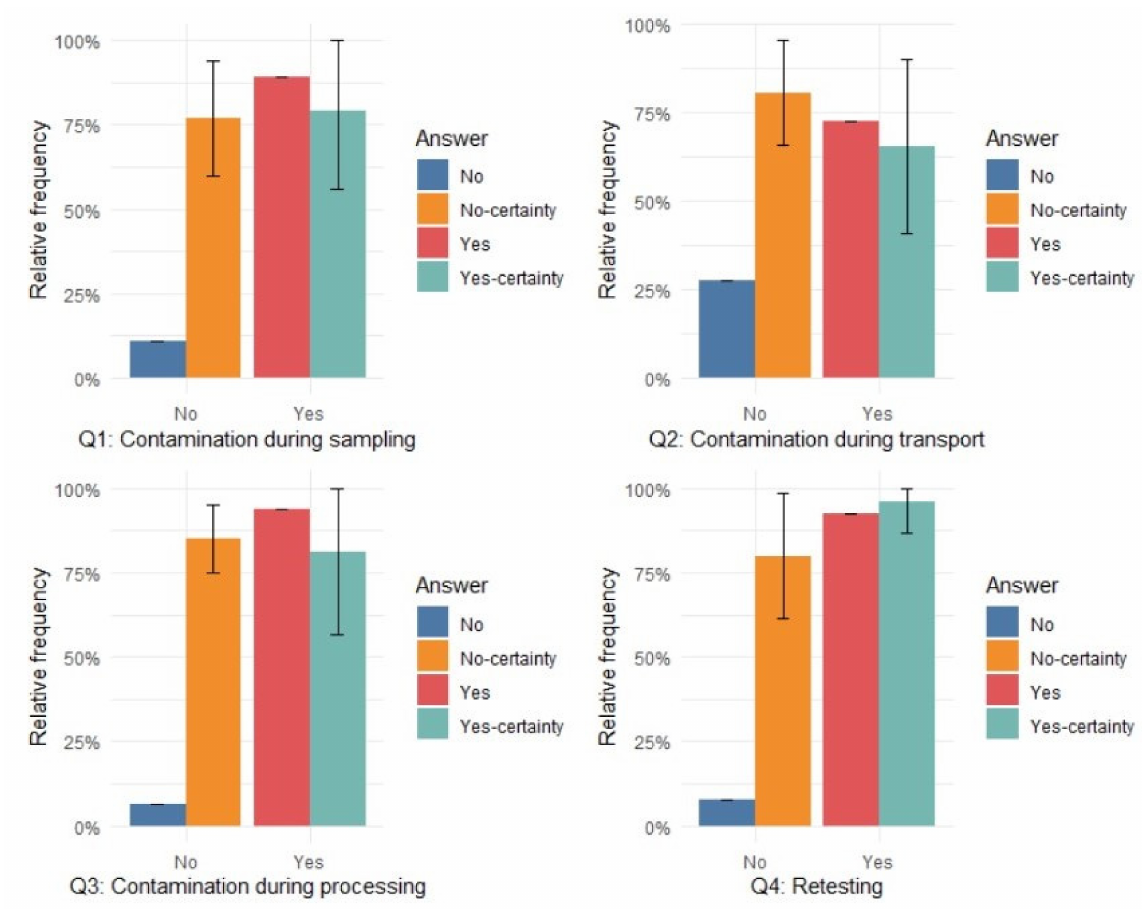
Figure 3. Poultry veterinarians (N = 65) responding to questions (Q1–Q3) on source of contamination of Salmonella samples in poultry breeding flocks leading to false positive routine Salmonella monitoring results and the need for making resampling and retesting possible of routine Salmonella monitoring positive results